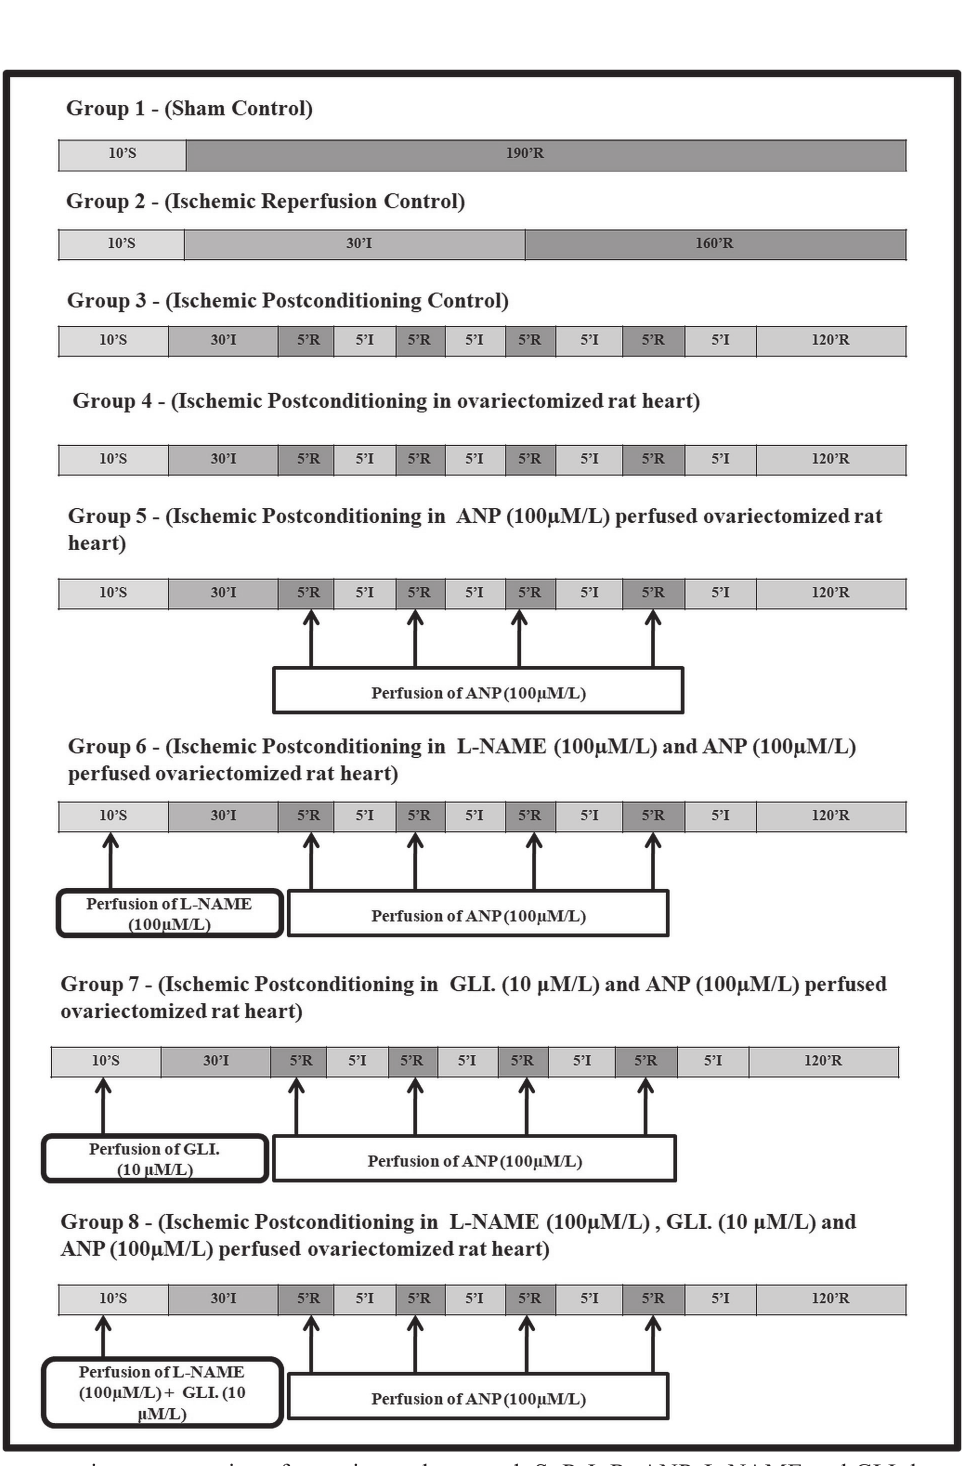
FIGURE 3 - Diagrammatic representation of experimental protocol . S, P, I, R, ANP, L-NAME and GLI denotes stabilization, perfusion, ischemia, reperfusion, atrial natriuretic peptide, N- nitro L-arginine methyl ester and Glibenclamide